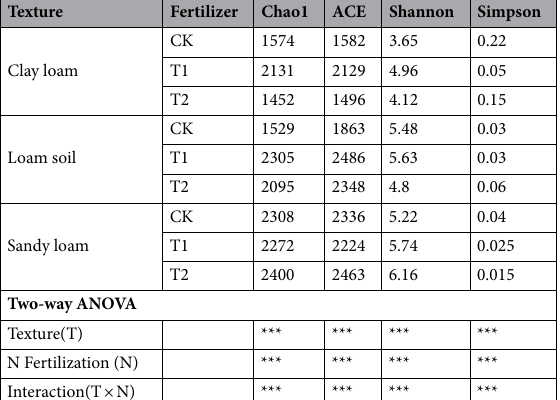
Table 3. The influence of fertilizer and soil texture on indexes of richness and diversity of bacteria community, as obtained from the pyrosequencing analysis. Different letters in the same column indicate significant differences (P < 0.05) among treatments. Significance levels: ***P <